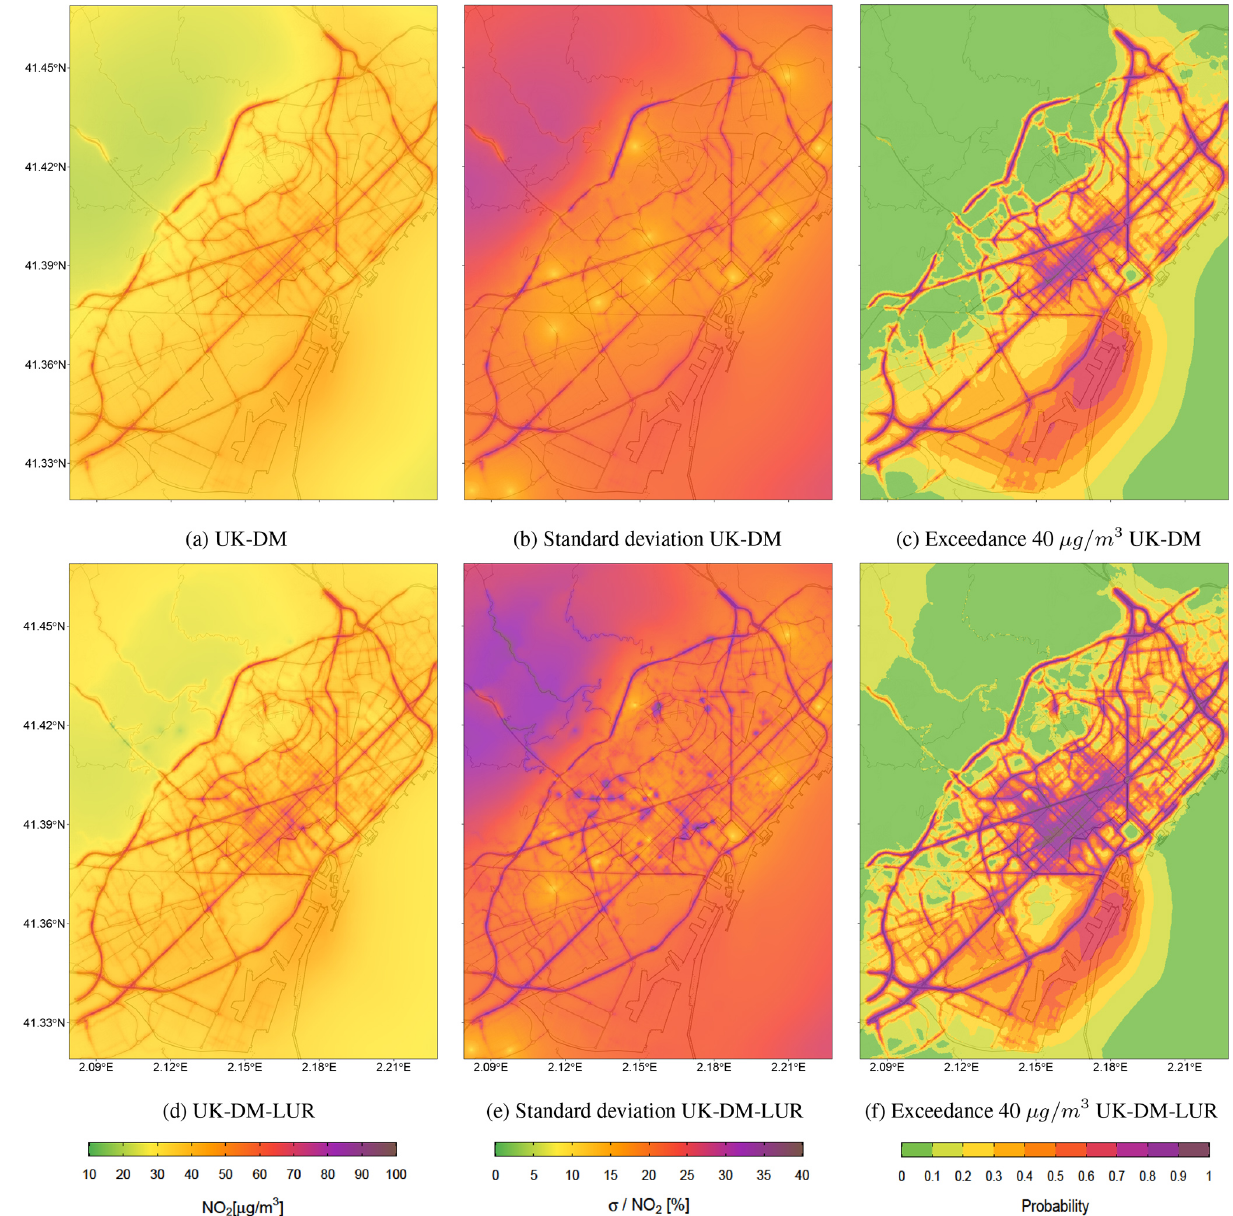
Figure 10. (a) NO 2 2019 annual map resulting from applying UK-DM with the annual values. (b) Relative uncertainty associated with the predictions in panel (a) . (c) Annual probability map of values exceeding the 40µgm − 3 NO 2 limit, using the values in panels (a) and (b) . (d) NO 2 2019 annual map resulting from applying UK-DM-LUR with the annual values. (e) Relative uncertainty associated with the predic- tions in panel (d) . (f) Annual probability map of values exceeding the 40µgm − 3 NO 2 limit, using the values in panels (d) and (e)